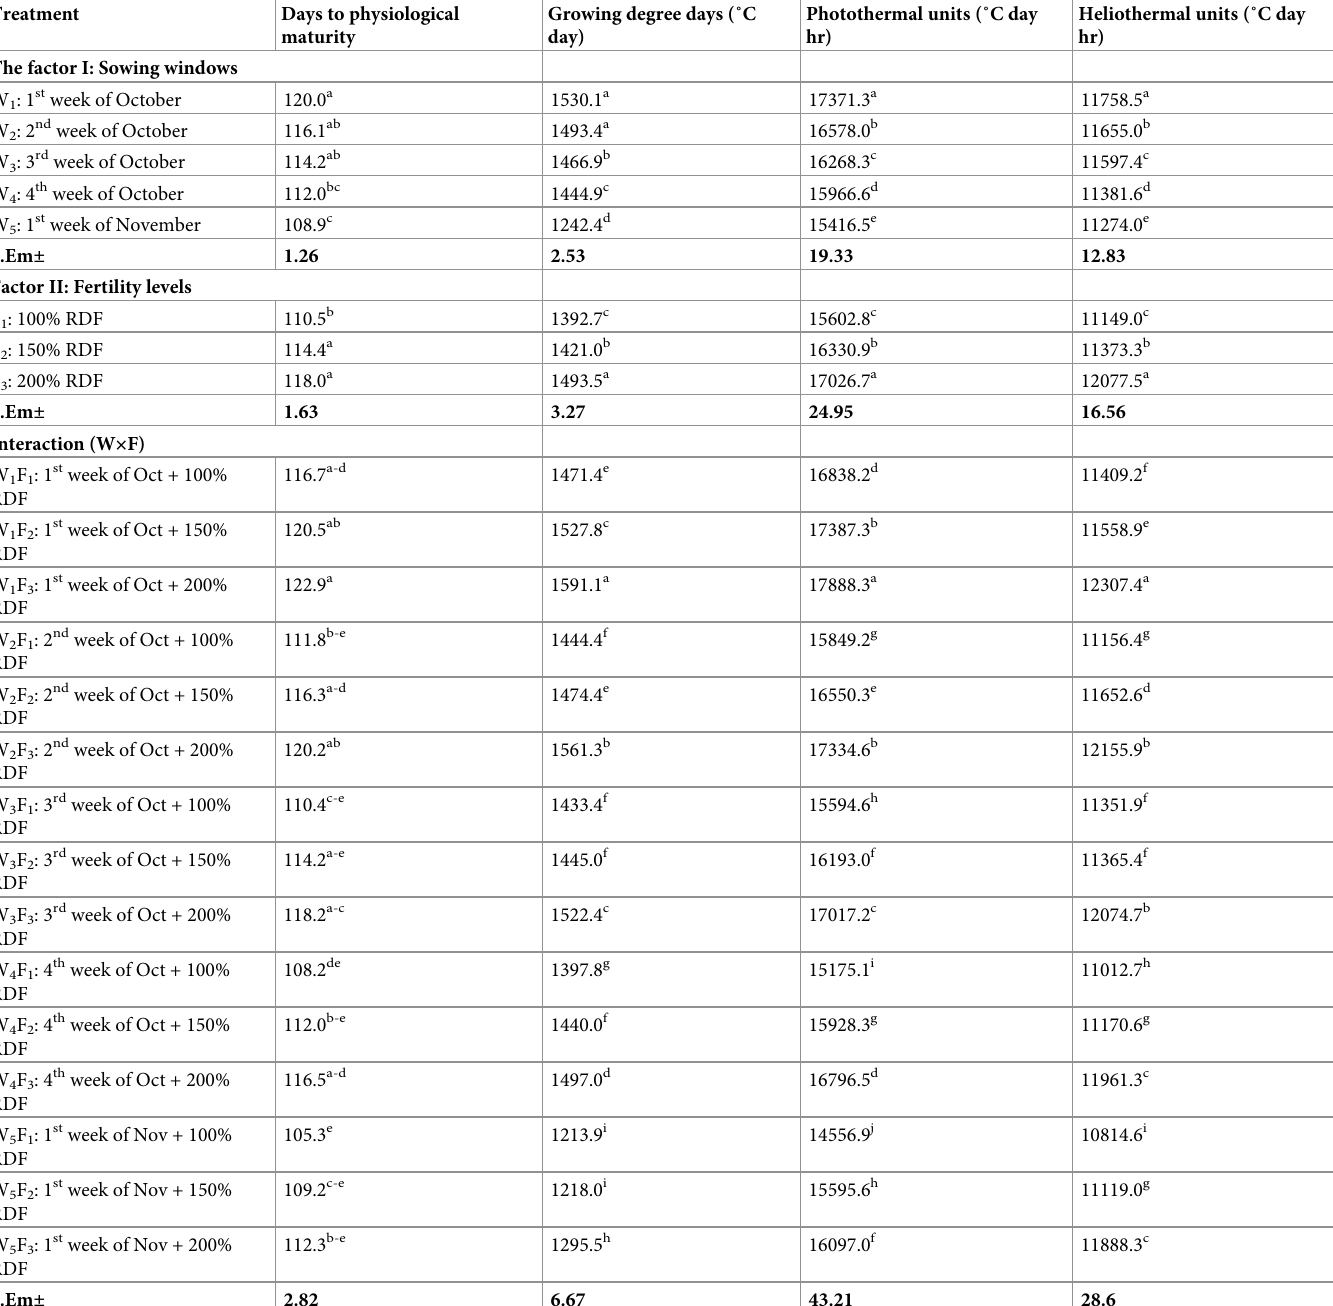
Table 2. Days to physiological maturity, growing degree days, photothermal units, and heliothermal units of winter maize as influenced by sowing windows and fer- tility levels.